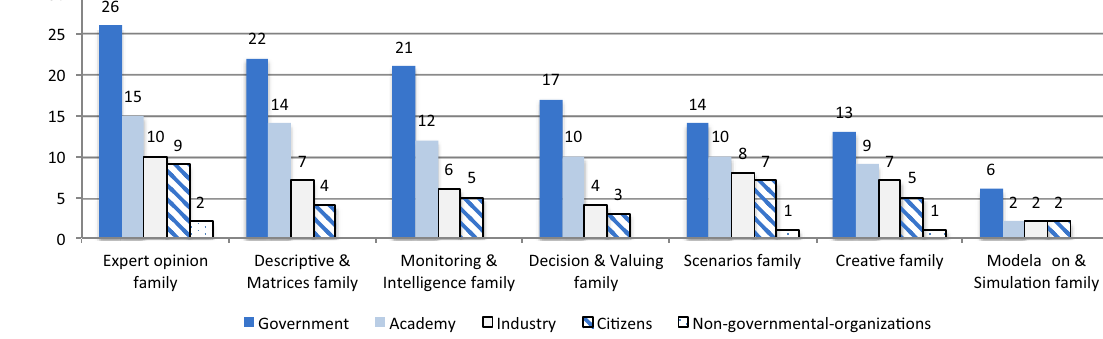
Fig. 13 Families of FTA methods per